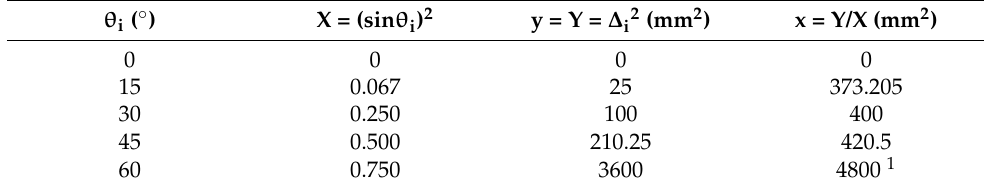
Table 2. Values for drawing the linear function (x, y).